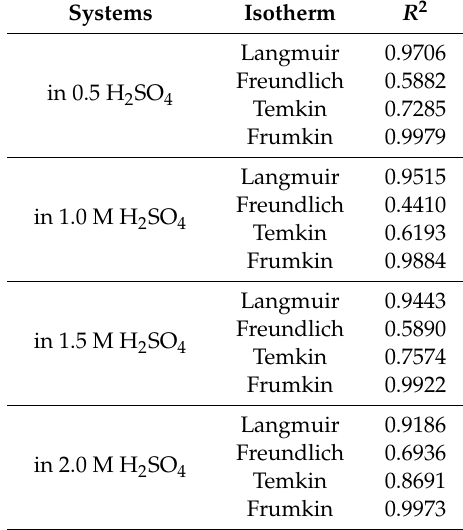
Figure 9. Langmuir ( a – d ), Freundlich ( e – h ), Temkin ( i – l ) and Frumkin isotherm ( m – p ) for the adsorption of the inhibitor on 304 SS surface in 0.5 M, 1.0 M, 1.5 M and 2.0 M H 2 SO 4 , respectively. Table 5. R –Square of various isotherm for the adsorption of the inhibitor on 304 SS surface in 0.5 M, 1.0 M, 1.5 M and 2.0 M H 2 SO 4 ,